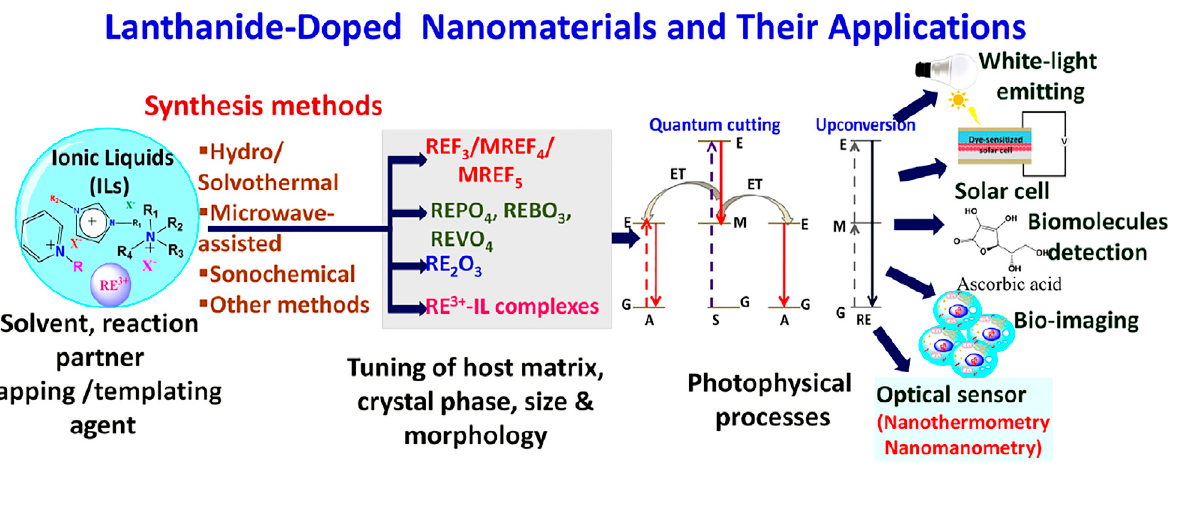
TABLE 1 | Melting point, viscosity, and electrical conductivity of ionic liquids (Faridbod et al., 2011; Wang et al., 2007; Shukla and Sah, 2013). Ionic